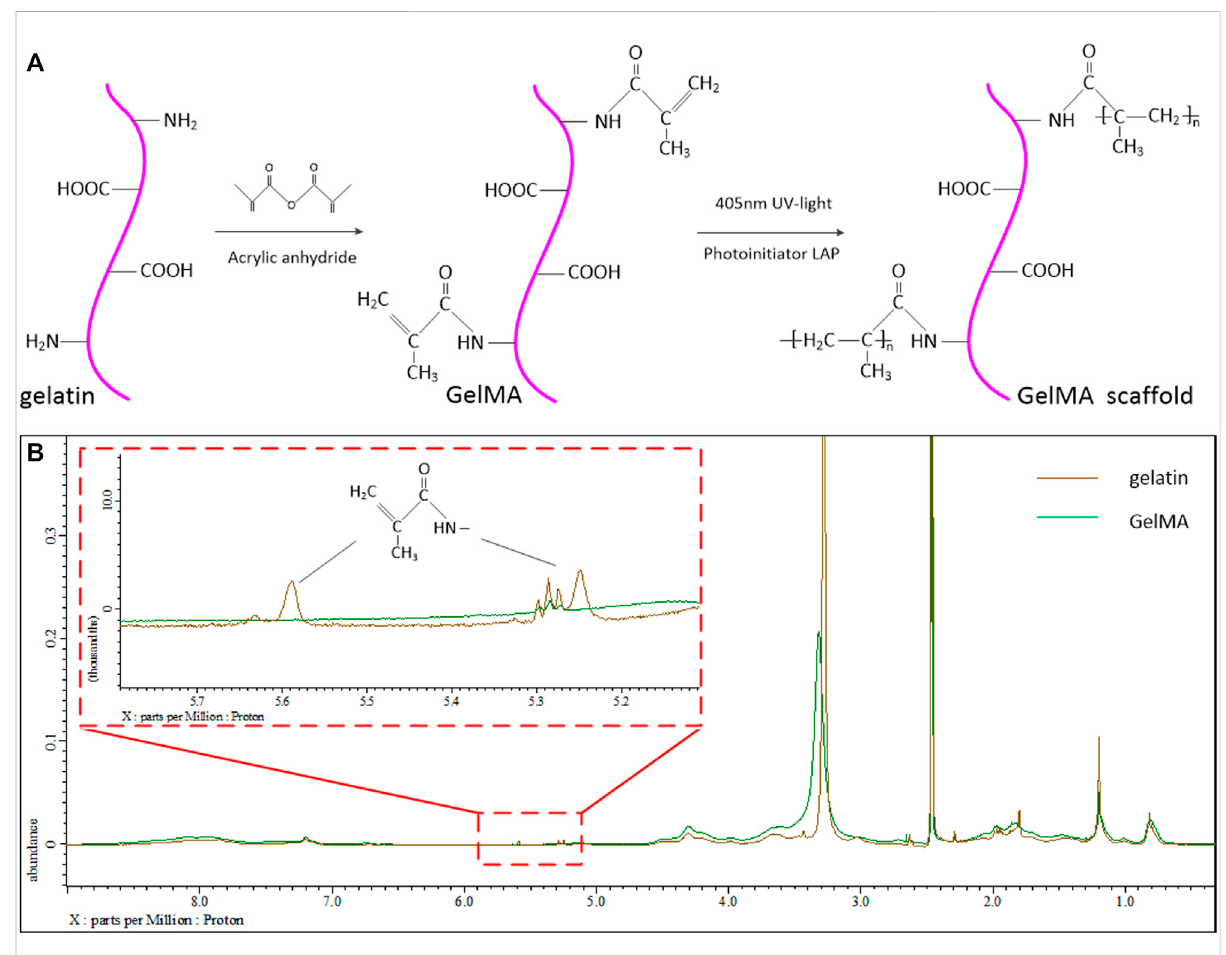
FIGURE 1 (A) Schematicdiagram of themodi fi cationprocess and UV-curing processof GelMA. (B) 1H NMRspectrum of thegelatinandmodi fi ed GelMA